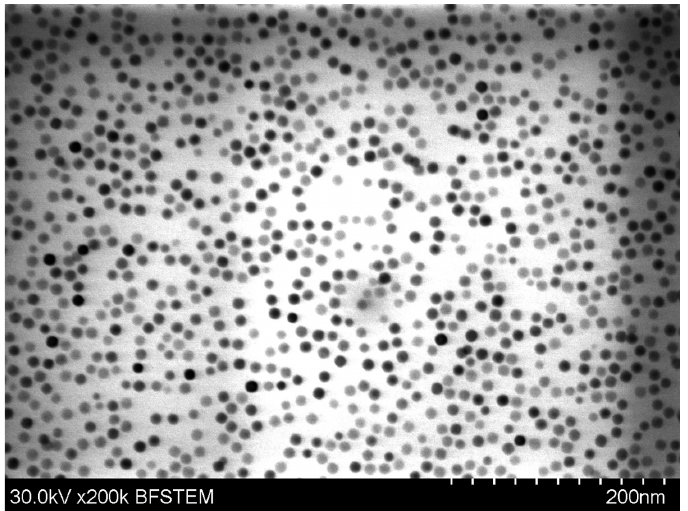
Figure 4. The morphologies of the magnetic nanoparticles for the synthesized hydrophobic systems. Representative TEM image of the iron oxide nanospheres. The samples have a regular spherical shape distribution. Figures show a round uniform structure of magnetic nanoparticles, well dispersed, with an average diameter of 10 nm.